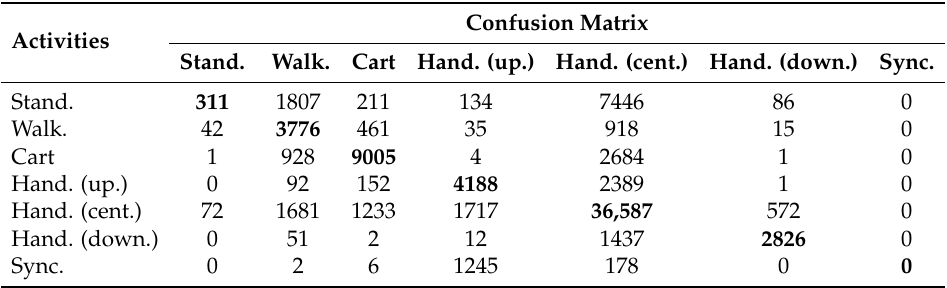
Table 11. Confusion matrix from the class predictions using tCNN with the softmax layer. Confusion Matrix Activities Stand.